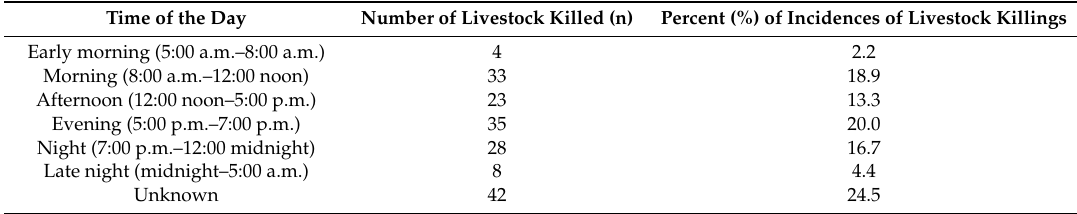
Figure 2. Number of livestock killed by north China leopards in and around the Tieqiaoshan Provincial Nature Reserve. Table 1. The daily pattern of livestock killings by north China leopards in and around the Tieqiaoshan Provincial Nature